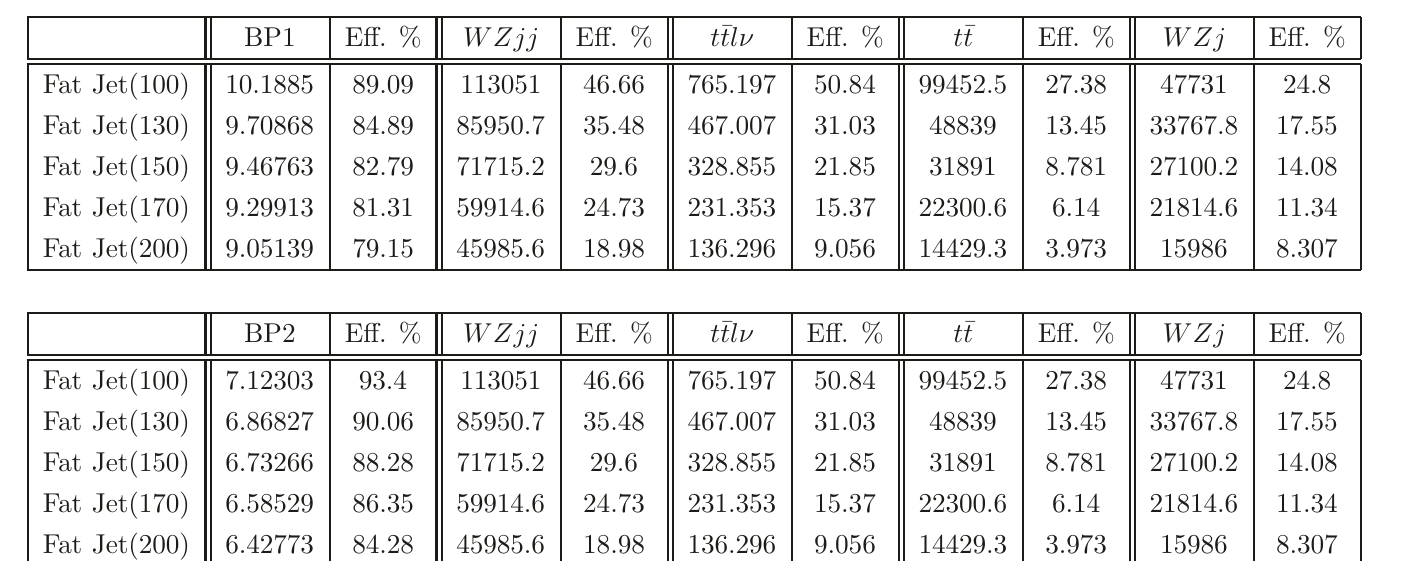
Table 7 . BP1 and BP2 benchmark points for the Z ′ -mediator case. Luminosity signal and SM background as explained in the text. The minimum p T in GeV required for the fat jet is given in parenthesis. The efficiencies are not